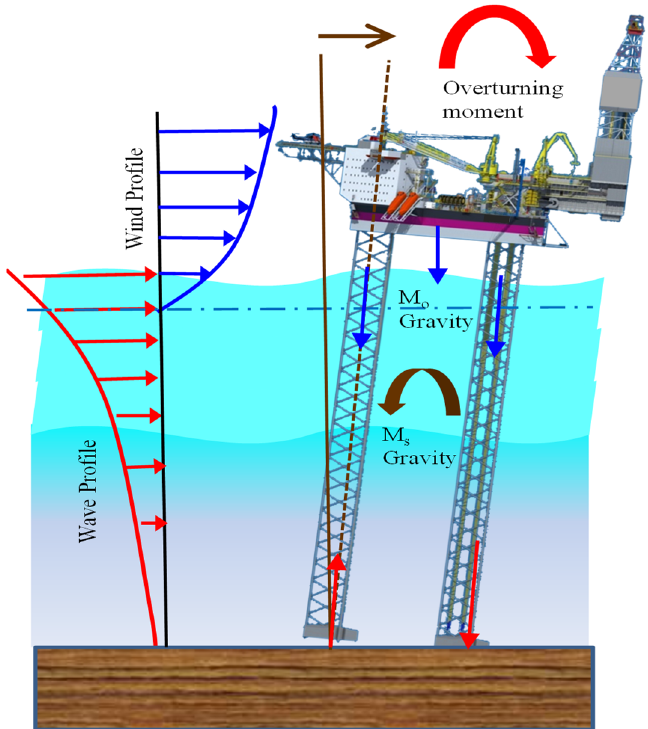
Figure 7. Overturning stability mode against external loads.